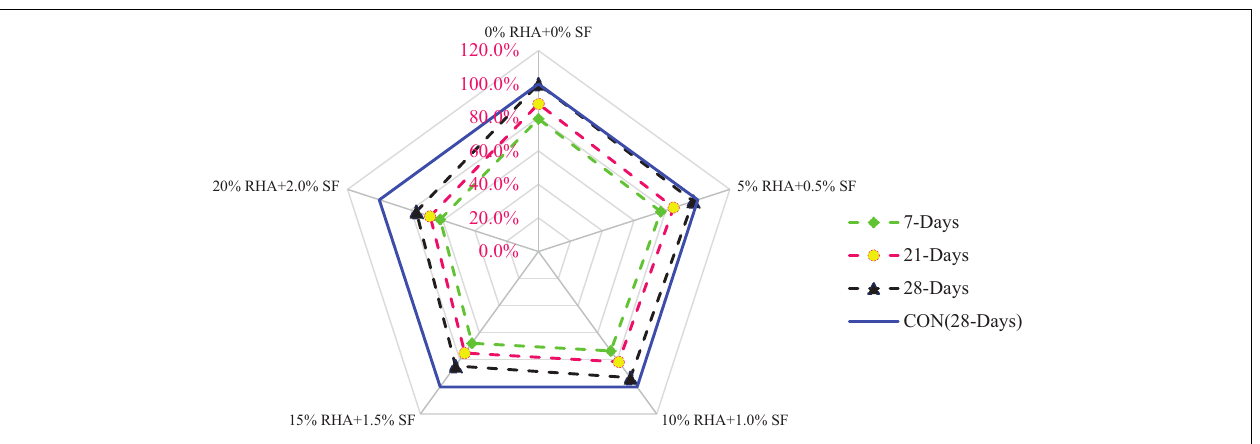
FIGURE 8 | Split tensile strength (with steel fibers and superplasticizer).